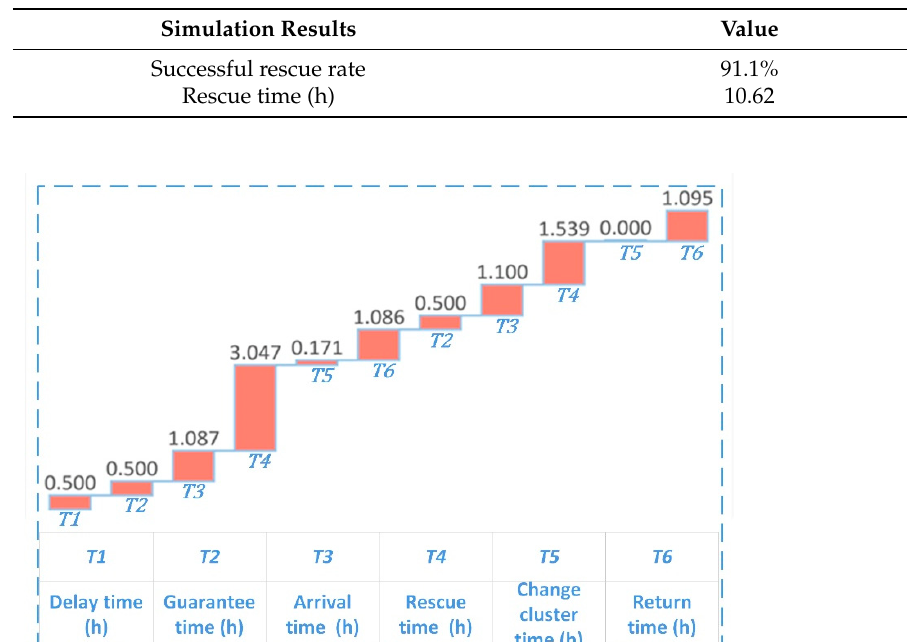
Figure 12. The TPM-0.5 of SRP for 45 PDTs. Table 2. The simulation result for 45 PDTs of the TPM-0.5.